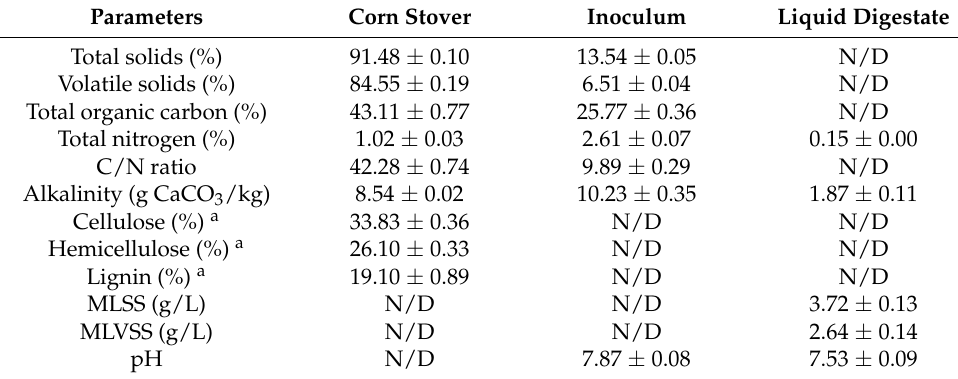
Table 1. Characteristics of